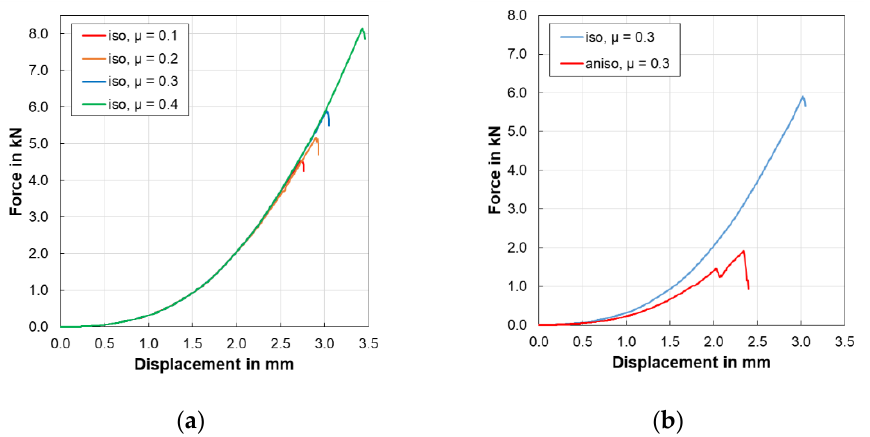
Figure 15. Force-displacement outputs with hybrid modelling method: ( a ) influence of coefficient of friction on isotropic model; ( b ) comparison between the isotropic and anisotropic model.